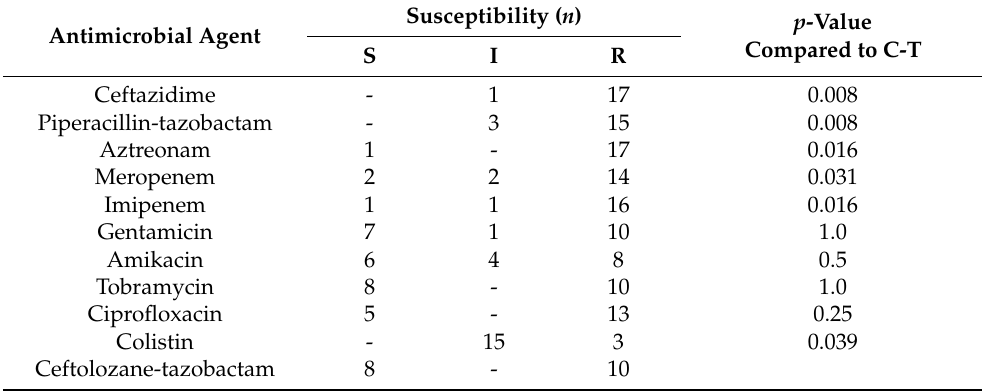
Table 4. The overall susceptibility of the 18 resistant (MDR, XDR or PDR) PA isolates to each antibiotic. Susceptibility ( n Antimicrobial Agent